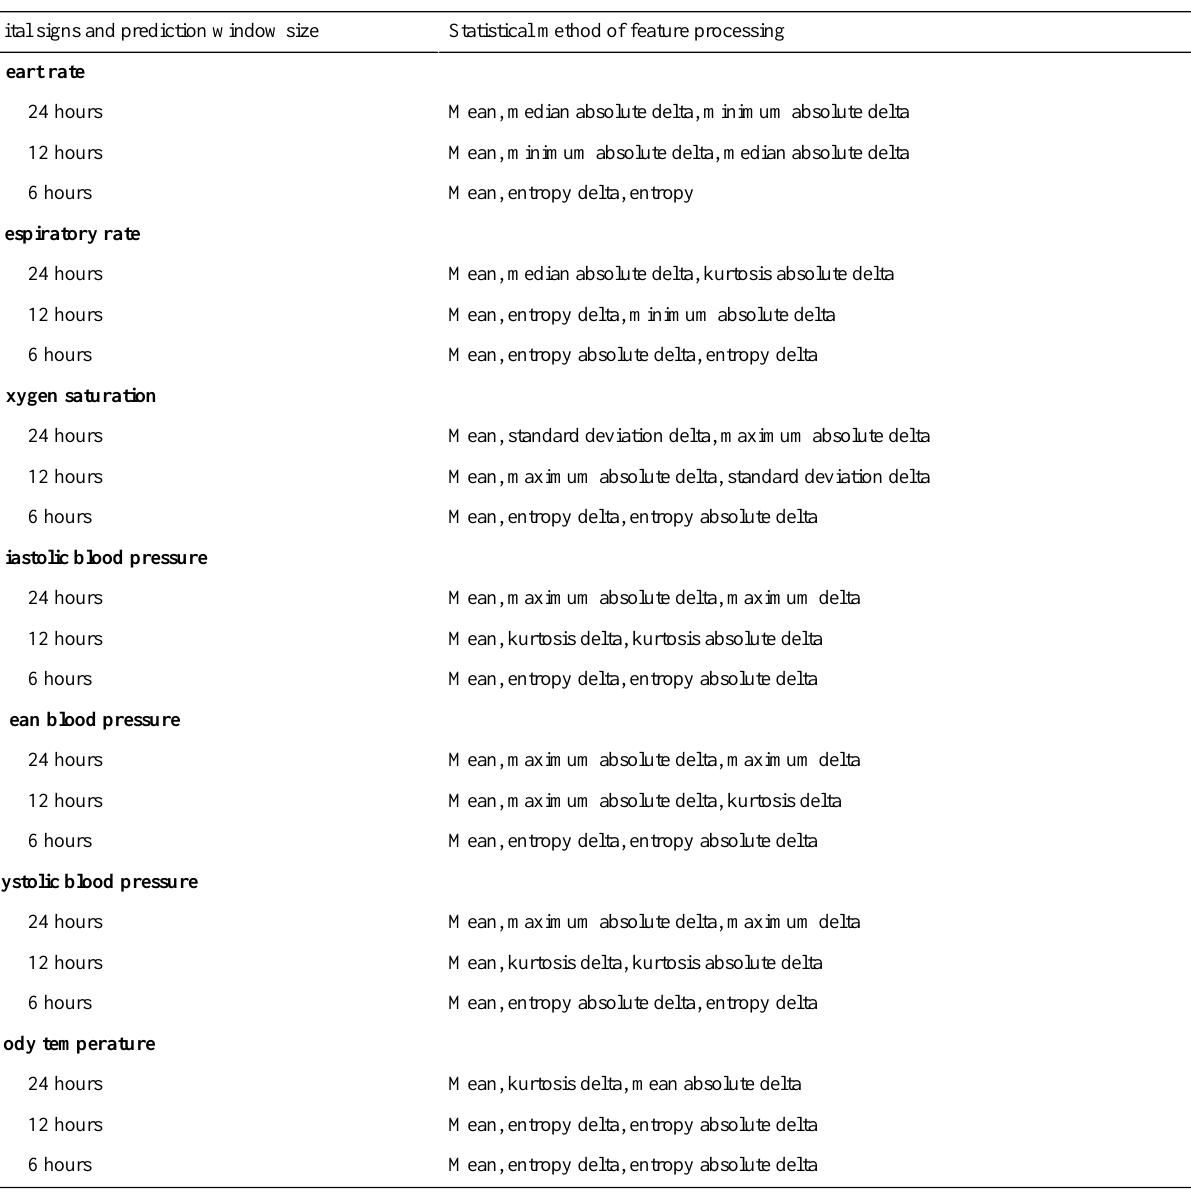
Table 4. Selected features from the proposed feature selection